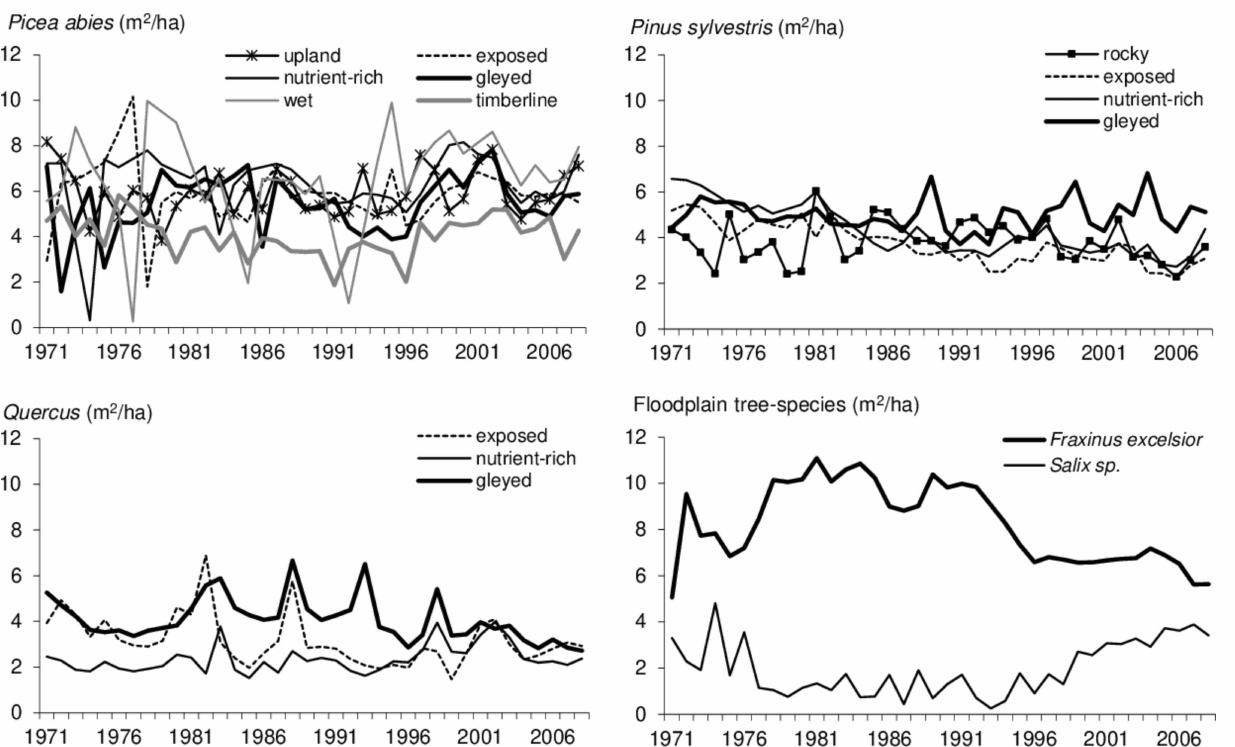
Figure 4. Current basal-area increment of forest stands selected on various soil